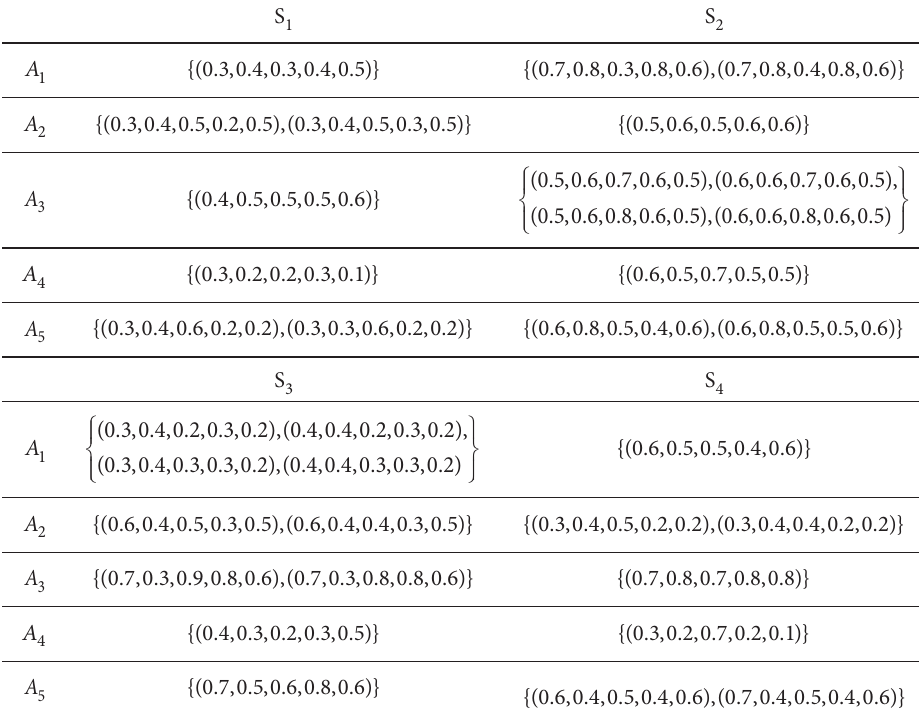
Table 1. Extended hesitant fuzzy decision matrix